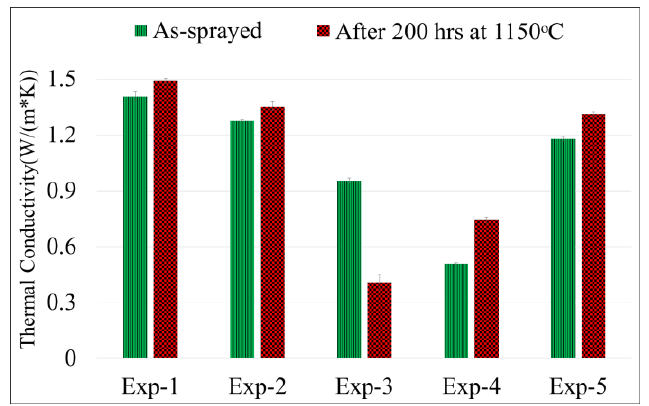
Figure 10. Thermal conductivity results for all five coatings before and after heat treatment showing an unusual significant decrease in Exp-3.